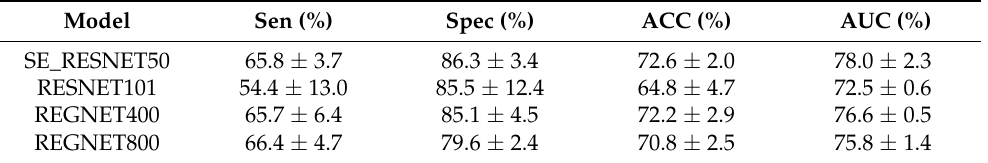
Table 3. Performance of the four basic models in the validation cohort.